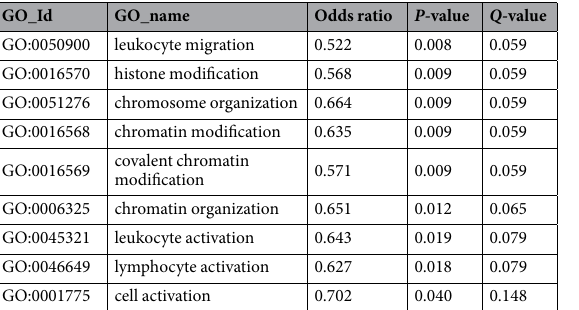
Table 1. List of GO terms enriched in expanded clones. GO terms included in the Venn diagrams (Fig. 5D) were analyzed to determine statistical significance. P -value and Q -value was determined by using Fisher’s exact test or Storey Tibshirani method 52 , respectively. Odd ratio was calculated as S P E A /S A E P (S P ; number of singleton IS present nearby genes related to a specific GO term, S A ; number of singleton IS absent nearby those genes, E P ; number of expanded IS present nearby those genes, and E A ; number of expanded IS absent nearby those